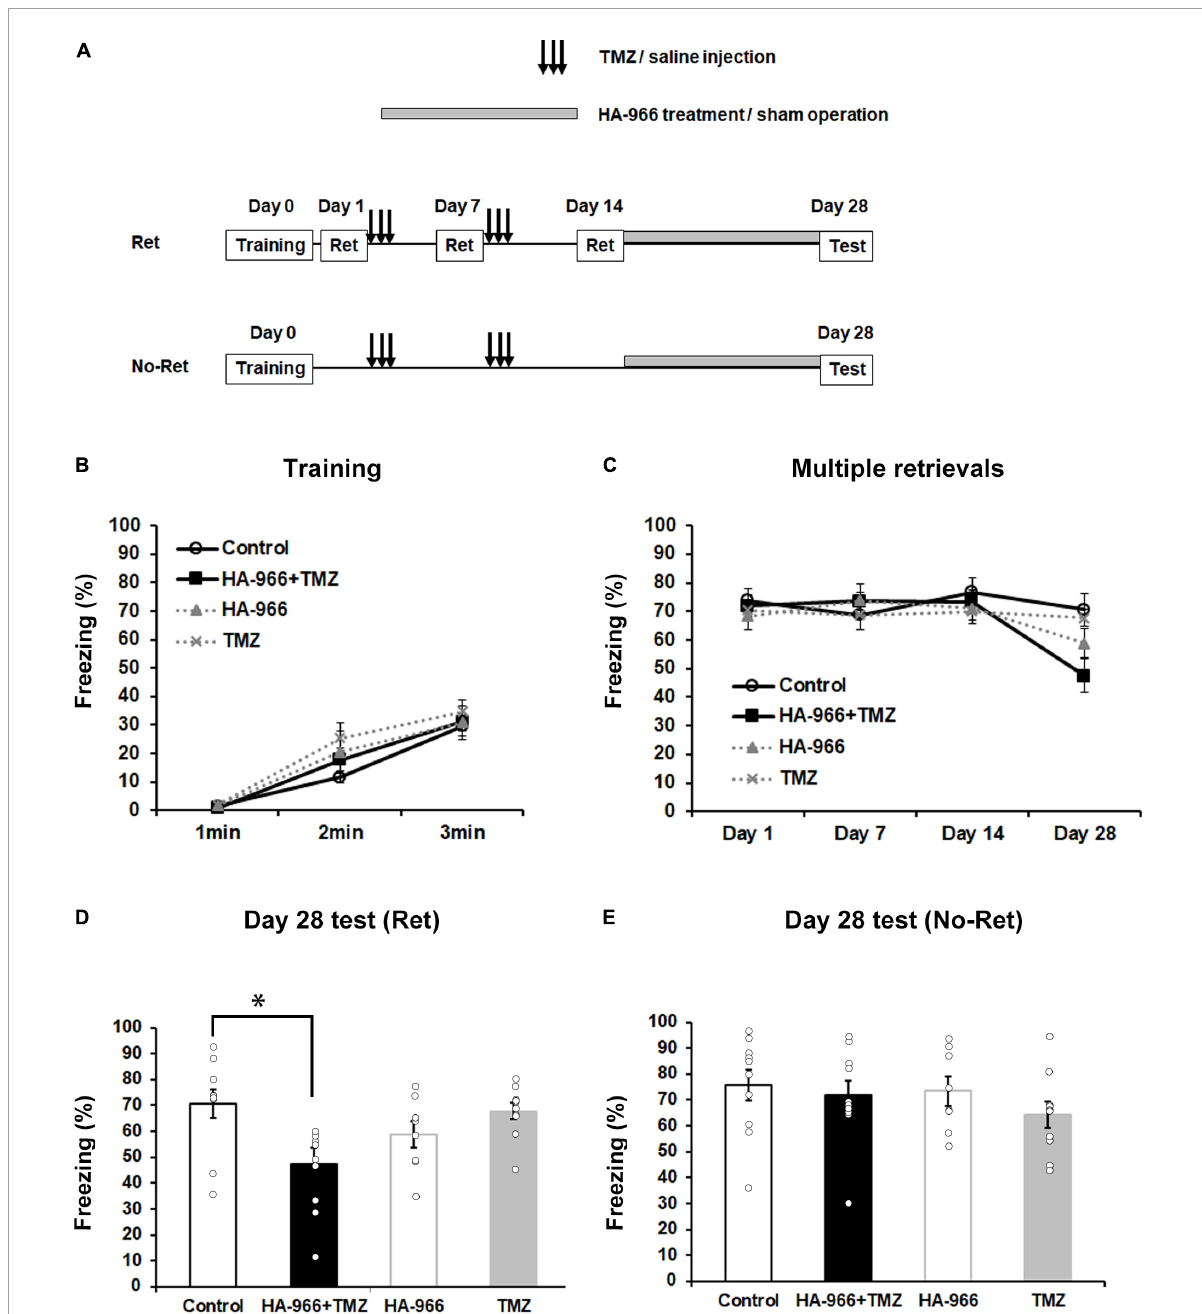
FIGURE3 Pharmacological blockade of D -serine signaling and hippocampal neurogenesis attenuates remote fear memory following multiple retrievals. (A) Experimental schedule for contextual fear conditioning, multiple retrievals, and drug treatments. Two different protocols, one with multiple retrievals (Ret) and another without memory retrieval (No–Ret) were used. In the two behavioral tests, mice were divided into four groups: control (saline injection and sham operation), TMZ + HA-966 (TMZ injection and HA-966 administration), HA-966 (saline injection and HA-966 administration), and TMZ (TMZ injection and sham operation) group, respectively. (B) During the fear conditioning, no significant difference could be observed in the freezing level between the four groups (control, n = 10; HA-966 + TMZ, n = 10; HA-966, n = 8; TMZ, n = 10). (C) During the course of four retrieval sessions, mice treated with TMZ and HA-966 exhibited a significant decrease in freezing levels on day 28 than that on day 1. In contrast, multiple retrievals did not affect freezing level in the other three groups. (D) TMZ + HA966 group ( n = 10) exhibited significantly lower freezing levels compared to the other three groups during memory test on day 28 following multiple retrievals. (E) Under the condition without intervention of multiple retrievals, no significant difference was observed in freezing level between four groups (control, n = 10; HA-966 + TMZ, n = 10; HA-966, n = 8; TMZ, n = 10) during the remote memory test on day 28. Data are presented as the means ± SEM. ∗ p <